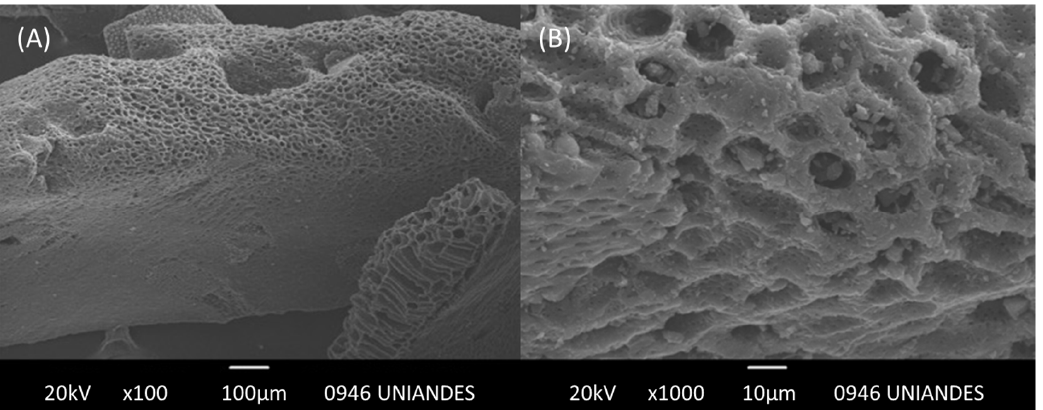
Figure 4. CO 2 adsorption isotherms at 273 K of activated carbons.